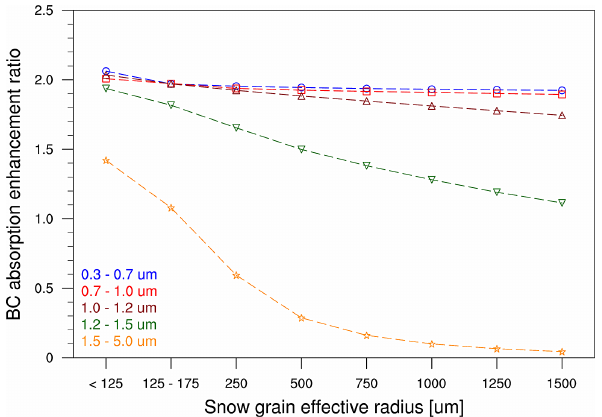
Figure 13. Spatial distribution of BC and dust direct radiative forc- ing at the surface and in the snow from the WRF-Chem simulations over North China in January–February